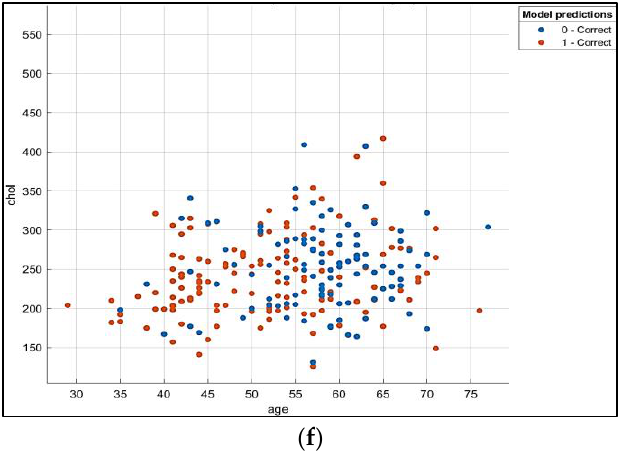
Figure 5. ( a ) SVM model with the correct predictions concerning the features ‘age’ and ‘cholesterol’. ( b ) KNN model with the correct predictions concerning the features ‘age’ and ‘cholesterol’. ( c ) AdaBoost model with the correct predictions concerning the features ‘age’ and ‘cholesterol’. ( d ) Bagged tree model with the correct predictions between ‘age’ and ‘cholesterol’. ( e ) Logistic regression model with the correct predictions concerning the features ‘age’ and ‘cholesterol’. ( f ) Gaussian naive Bayes model with the correct predictions concerning the features ‘age’ and ‘cholesterol’.